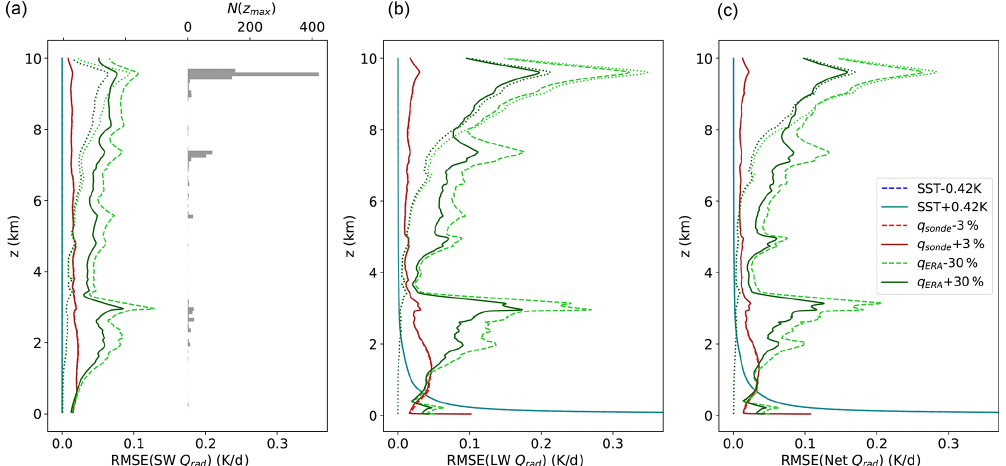
Figure 7. Root-mean-square error estimates in shortwave (a) , longwave (b) , and net heating rates (c) for perturbations in SST skin (blue), ERA5 humidity profiles (green), and sonde humidity measurements (red) for the 1314 daytime profiles that have valid data starting at 40m. Dashed curves show negative perturbations, solid curves show positive perturbations, and dotted green curves show ERA5 humidity perturbations restrained to the 1117 daytime profiles that have valid data at all levels between 40m and 8km. The horizontal gray bars on the left panel show the frequency distribution in the maximum level measured ( z max